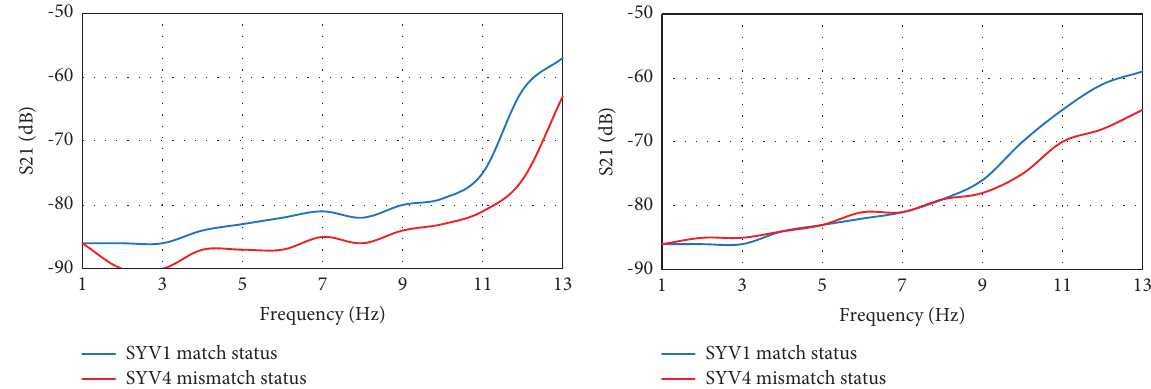
Figure 6: S21 parameters measured when the power cable is connected to 75 Ω and 50 Ω